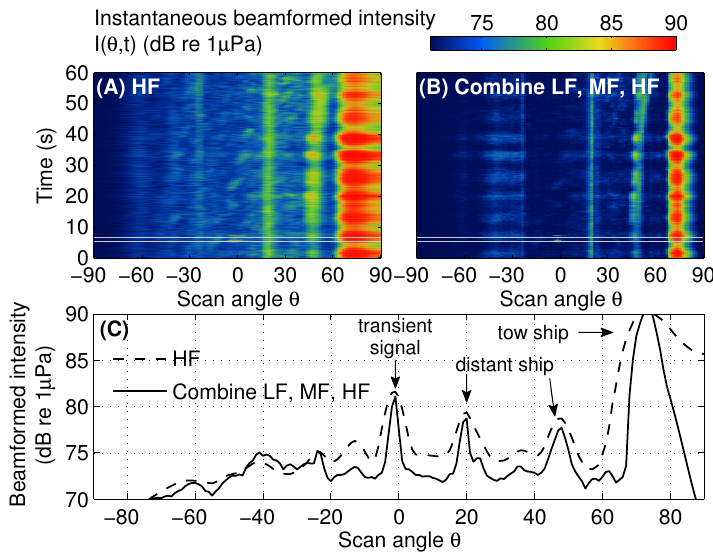
Figure 7. Two-dimensional beam-time series I B ( θ , t ) converted from acoustic pressure-time series measured by sensors across the receiver array using the conventional time-domain beamforming for ( A ) the uniformly-spaced HF subaperture, and ( B ) the newly defined subarray that combines LF, MF and HF subapertures. The received vocalization pressure level within the shading area bounded by the gray solid lines in ( A , B ) are averaged and shown in ( C ) as a function of scan angle θ . The ambient noise floor is reduced by an approximately 4 dB because of an approximate factor of 2 narrower beam width provided by the nonuniformly-spaced subarray.